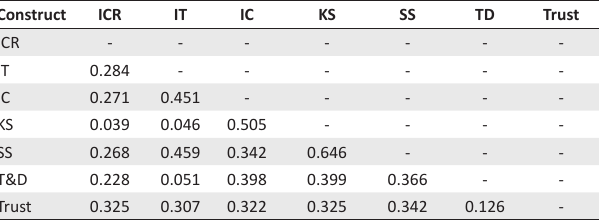
TABLE 4: Hetrotrait-Montrait ratio.